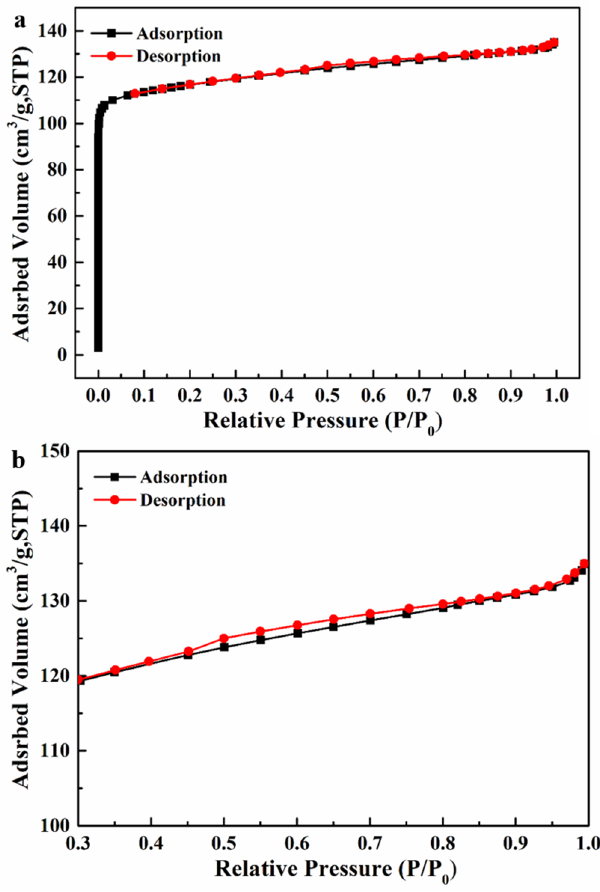
Figure 2. Nitrogen adsorption and desorption isotherm curves of silicalite-1 zeolites powders. ( b ) was the magnified segment of ( a ). Table 1. Results from N 2 sorption measurements for the silicalite-1 zeolites